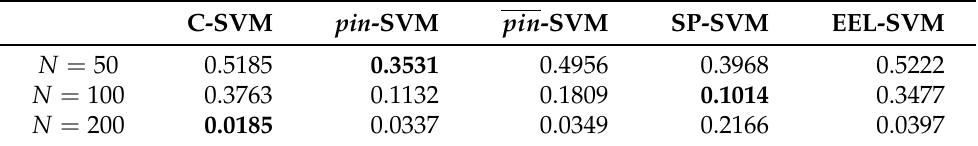
Table 1. Distance (13) between various SVM classifiers and Bayes classifier for non-contaminated synthetic data. Lowest distance along each row in